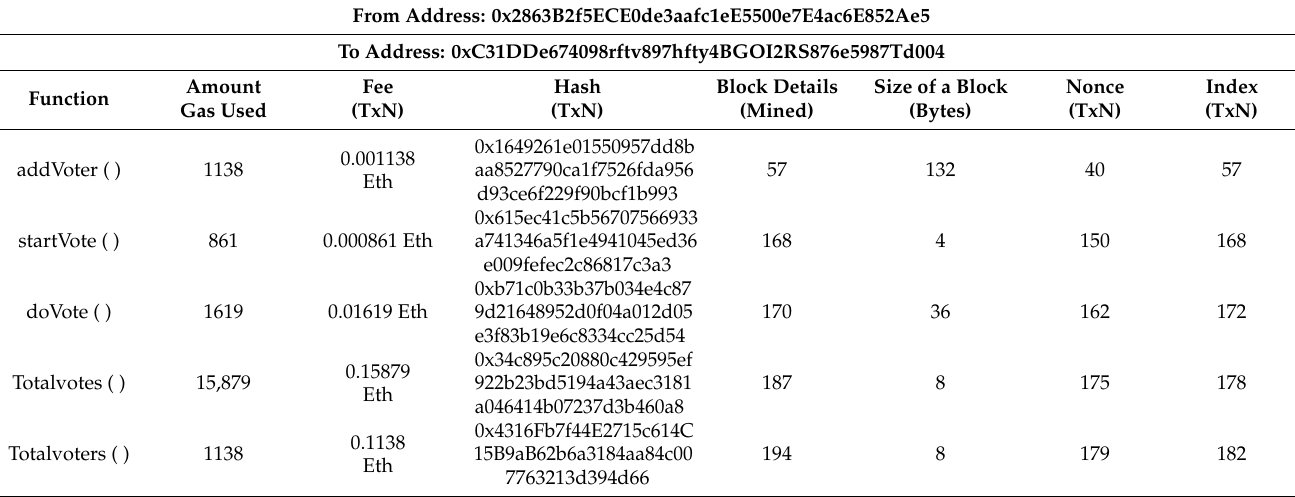
Table 4. Smart contracts operational cost over blockchain environment.